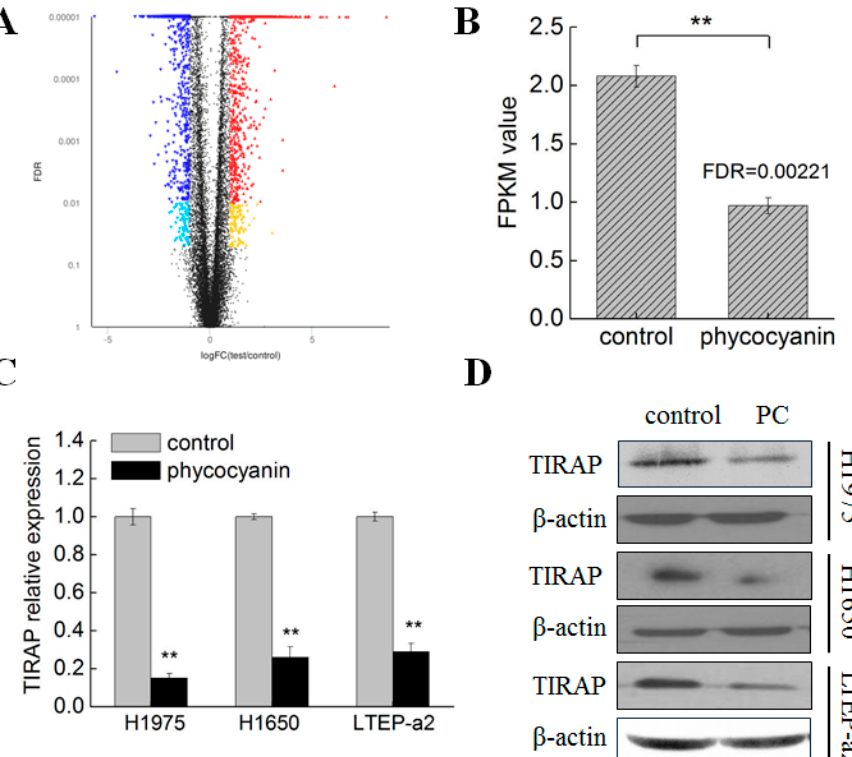
Figure 3. Phycocyanin reduced the expressions of TIRAP in non-small cell lung cancer cells. ( A ) RNA-seq analysis of differentially expressed genes between control and phycocyanin-treated LTEP-a2 cells. The horizontal axis indicates expression changes (log) of the genes and the vertical axis indicates the false discovery rate (FDR, adjust p value). Black dots are genes with no significant discrepancy. Dark and light blue dots are genes significantly down-regulated with FDR < 0.01 or 0.01 < FDR < 0.05, respectively. Red and yellow dots are genes significantly up-regulated with FDR < 0.01 or 0.01 < FDR < 0.05, respectively. ( B ) RNA-seq analysis of TIRAP expression in control and phycocyanin-treated LTEP-a2 cells. The duration of phycocyanin treatment was 48 h before cell collection and RNA extraction. ( C ) qRT-PCR analysis of TIRAP expressions in H1975, H1650, and LTEP-a2 cells after phycocyanin treatment. ( D ) Western blot analysis of TIRAP expressions in H1975, H1650, and LTEP-a2 cells after phycocyanin treatment for 72 h. PC, phycocyanin treatment groups; TIRAP, TIR domain-containing adaptor protein. Bars represent mean ± SD. *, p < 0.05; **, p <